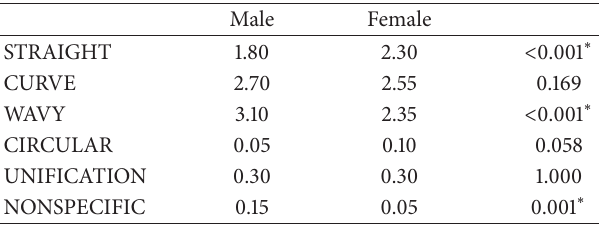
Table 4: Table showing comparison of rugae patterns among males and females of dentulous and edentulous